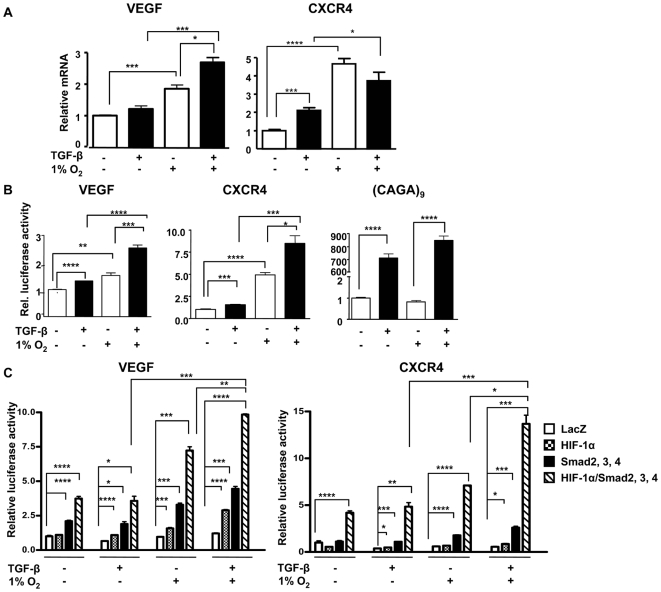
Hypoxia and TGF-β increase VEGF and CXCR4 mRNA expression and promoter activity.(A) MDA-MB-231 cells were cultured ± TGF-β (5 ng/mL) ± 1% O2 during 24 h and total RNA was extracted. VEGF and CXCR4 mRNA expression (mean ± SEM) was measured by semi-quantitative RT-PCR (n = 3). * P<0.05, *** P<0.005, **** P<0.001, using an unpaired Student's t test. (B) HepG2 hepatocarcinoma cells co-transfected with a renilla luciferase plasmid (phRL-CMV) and a pGL3 plasmid containing a fragment of the human VEGF (3.3 kb) or CXCR4 (2.6 kb) promoter, or the TGF-β-sensitive (CAGA)9 promoter were treated ± TGF-β (5 ng/mL) and ± 1% O2 during 24 h before measuring dual-luciferase activity. (C) MDA-MB-231 breast cancer cells were transfected with a pGL3 plasmid containing the human VEGF or CXCR4 promoter and the phRL-CMV plasmid, as well as plasmids to overexpress HIF-1α and/or Smad2, 3 and 4. Cells were treated ± TGF-β (5 ng/mL) ± 1% O2 during 24 h before measuring dual-luciferase activity. Results are expressed as the mean ± SEM (n = 3) of the relative luciferase activity. * P<0.05, ** P<0.01, *** P<0.005, **** P<0.001, using an unpaired Student's t test.